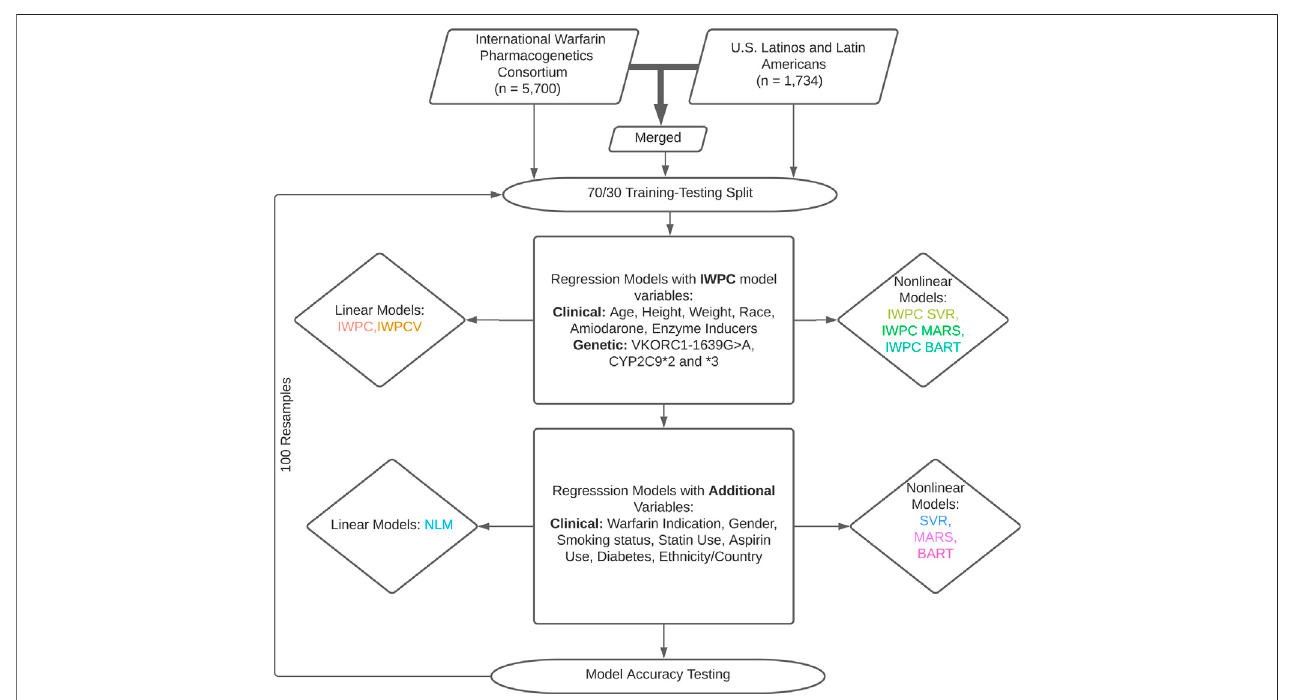
FIGURE 1 | Dose Prediction Algorithm Creation and Testing. International Warfarin Pharmacogenetics Consortium (IWPC) data and data from US Latinos and Latin Americans (ULLA) were used for prediction independently and merged to test a combined sample. Linear and nonlinear models were fi t with IWPC model variables and a set of extended variables in addition to IWPC predictors after a 70/30 training-testing split. All models were assessed for their ability to predict dose within 20% of actual. 100 replicates were performed from data splitting to model